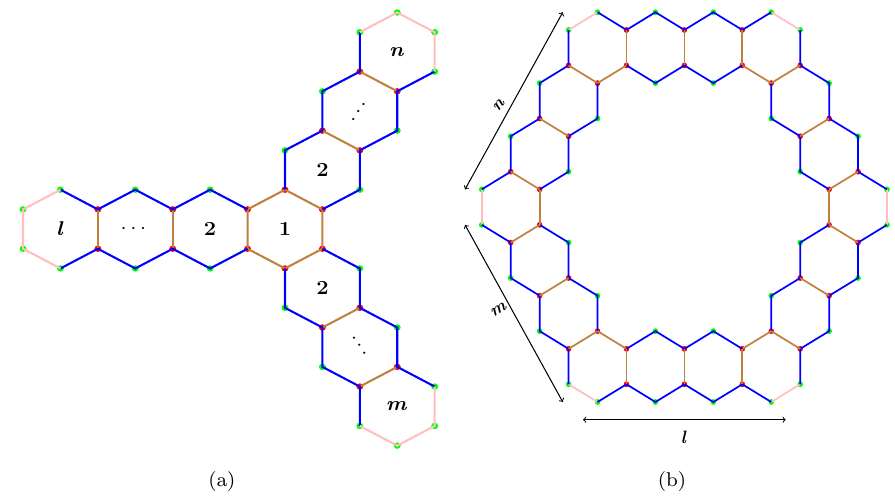
Figure 1: ( a ) S tarphene l m n St , , ( ) structure and ( b ) zigzag - edge coronoid l m n ZC , , ( )